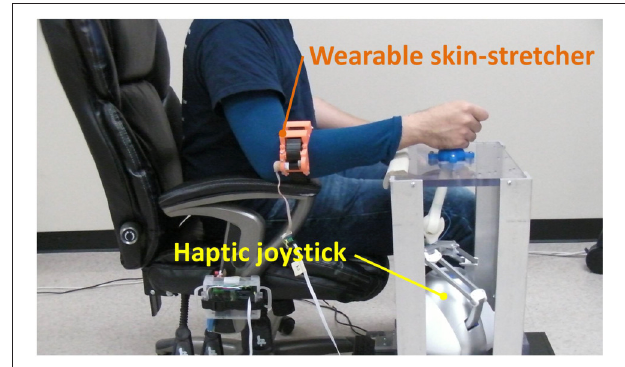
FIGURE 3 | Custom-developed two sensory augmentation devices: the wearable skin-stretcher mounted on a subject’s forearm and the 2D haptic